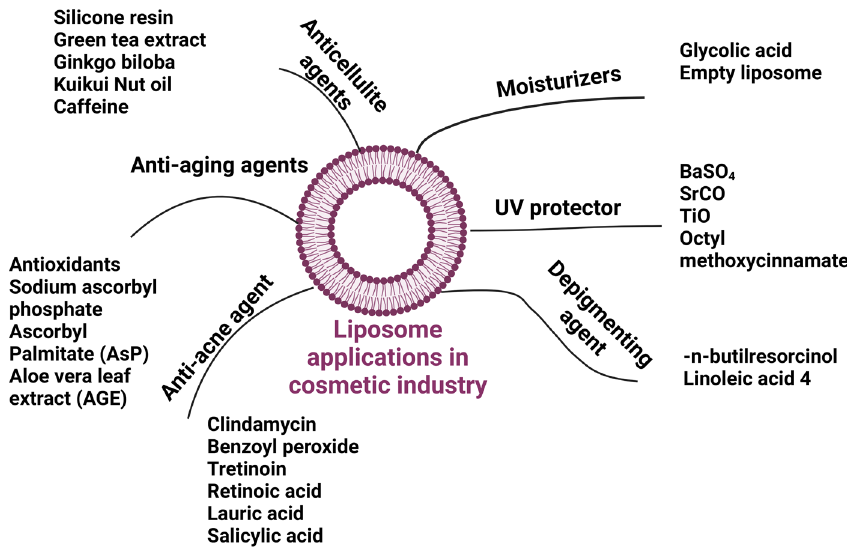
Figure 5: Liposome applications in the cosmeceutical industry. Created with BioRender.com.